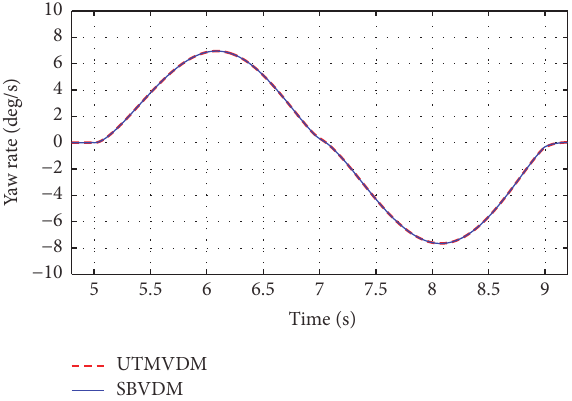
Figure 14: Longitudinal velocity results for sinusoidal steering test.